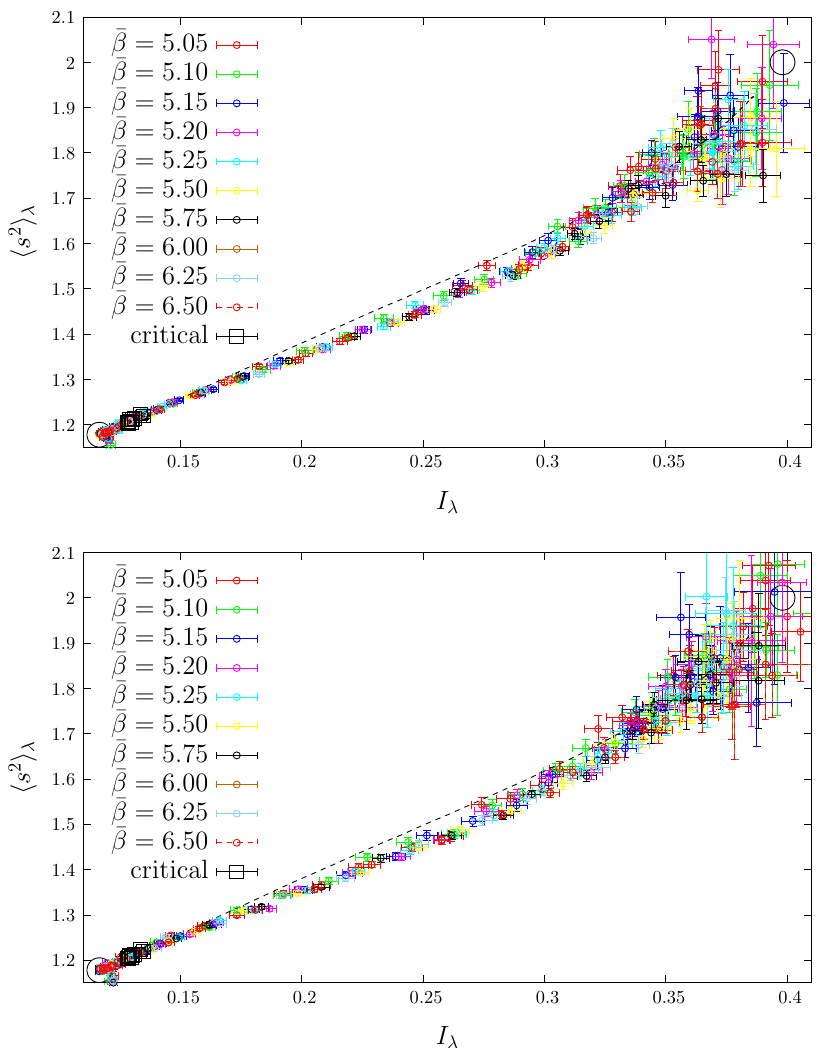
Figure 14 . Shape analysis. Each data point corresponds to the pair ( I λ , the same point λ in the spectrum. The pairs corresponding to the mobility edges for the various couplings are shown as black squares. In the top panel N s = 64, while in the bottom panel N s = 72. Results for different lattice couplings and different volumes all lie approximately on the same curve. The points corresponding to RMT and Poisson statistics are denoted with circles. The curve corresponding to the sinh-kernel is shown with a dashed